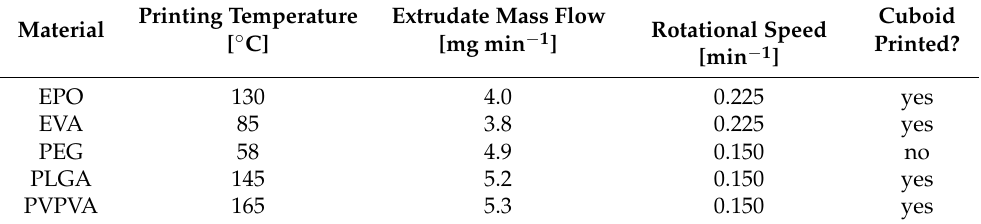
Table 2. Processing parameters used for the proof-of-concept prints of the different materials.